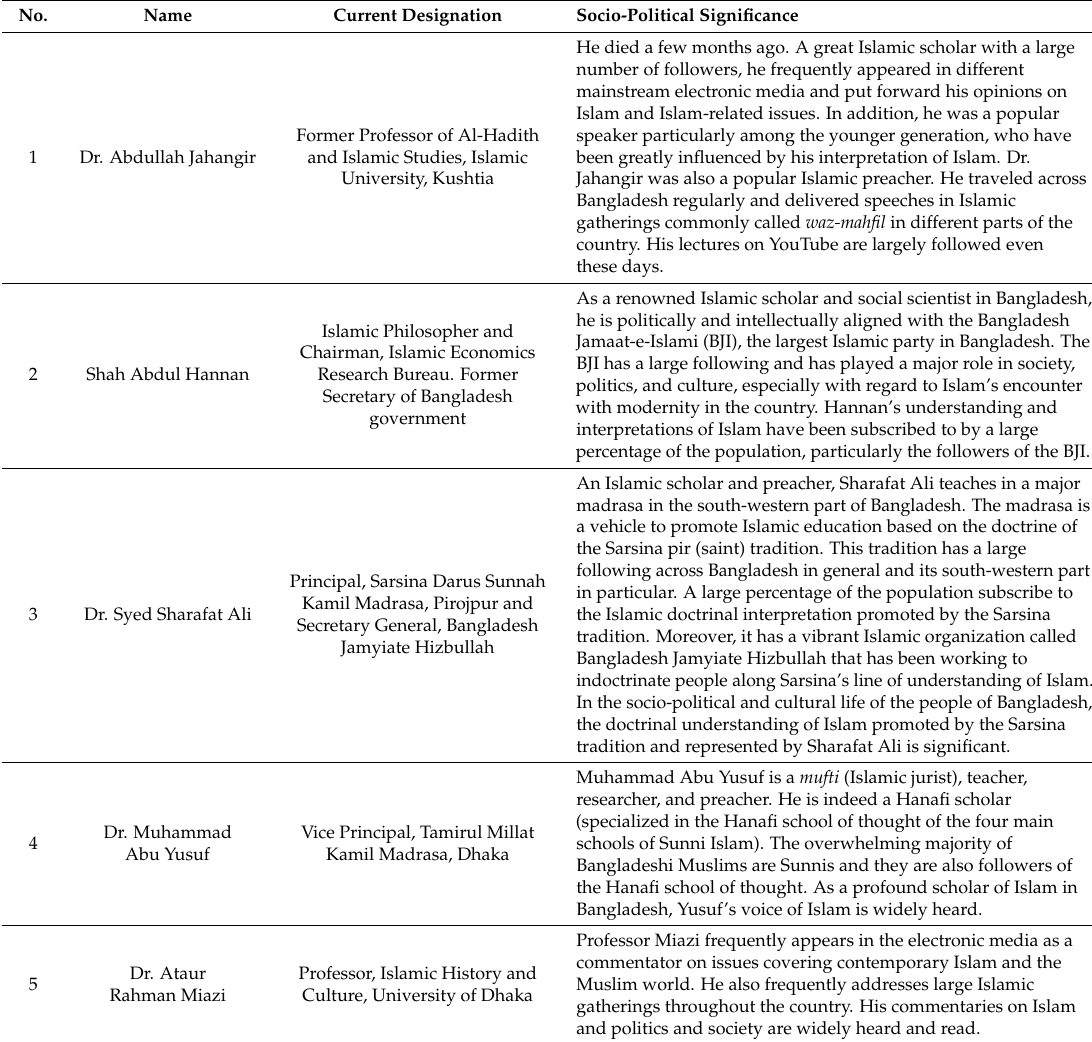
Table 1. Islamic scholars in Bangladesh